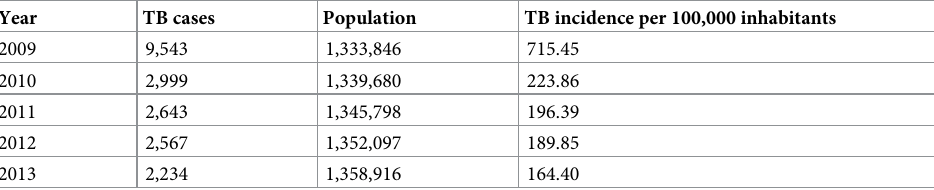
Table 1. TB incidence and actual TB cases over a 5-year period